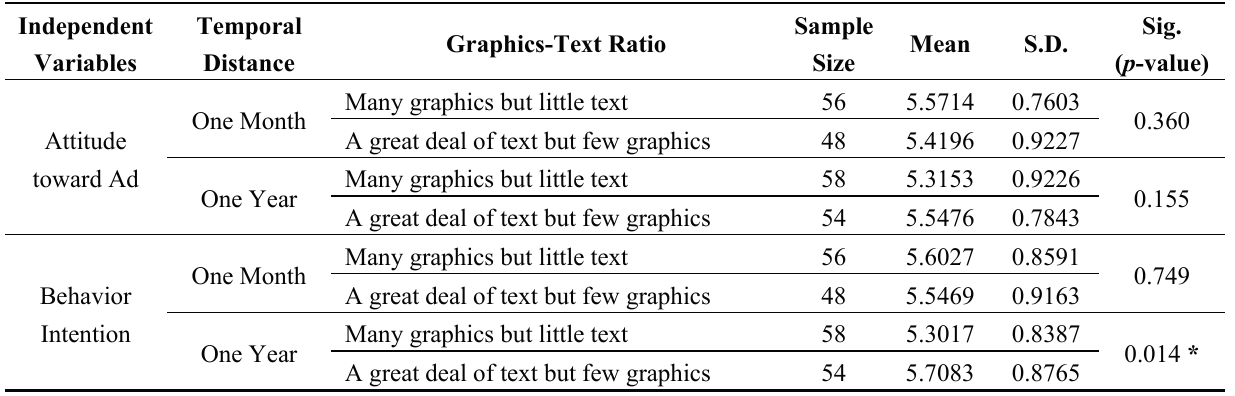
Table 6. Interactions between temporal distance and the graphics-text